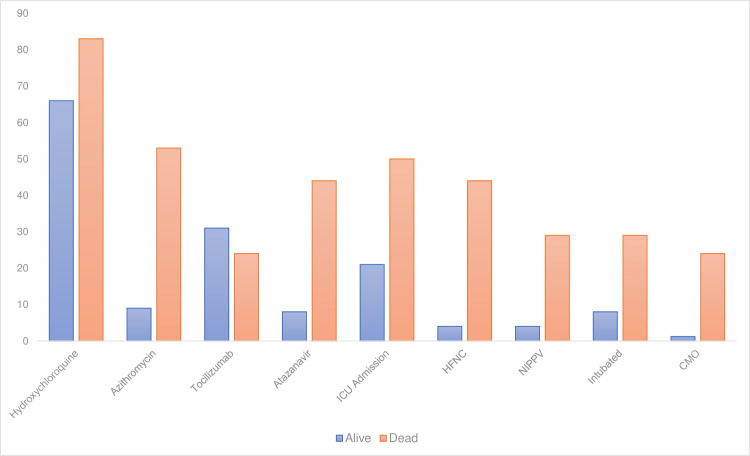
Medical and supportive interventions in COVID-19+ patients according to clinical outcome.ICU = Intensive Care Unit; HFNC = High flow nasal canula; NIPPV = Non-invasive positive pressure ventilation; CMO = comfort measures only.